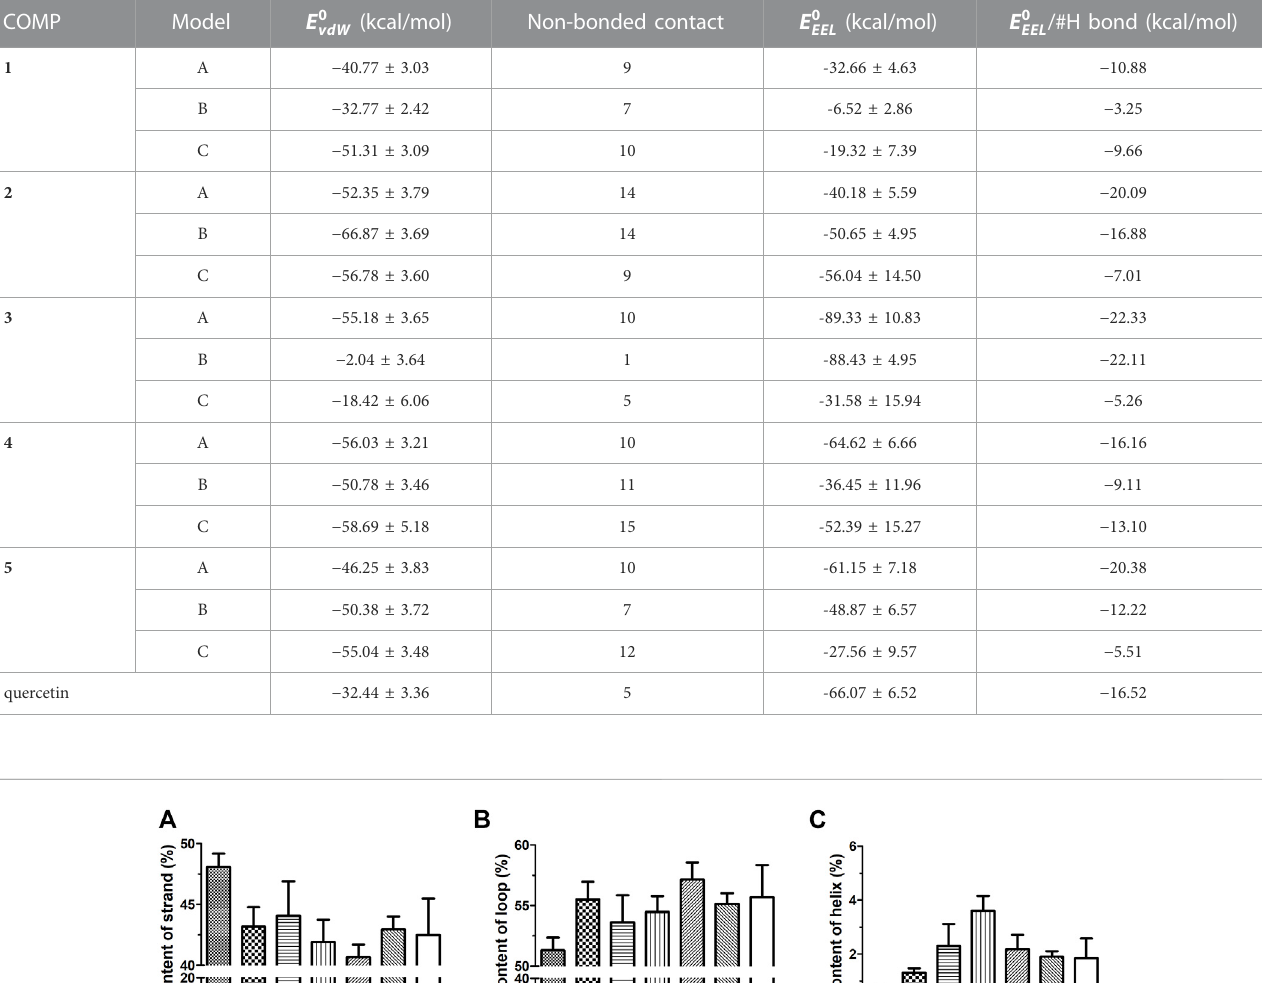
TABLE 3 A list of van der Walls force ( vdW ) and electrostatic interaction ( EEL ) of enthalpy of COMP-fPrP 170 – 229 complexes. COMP